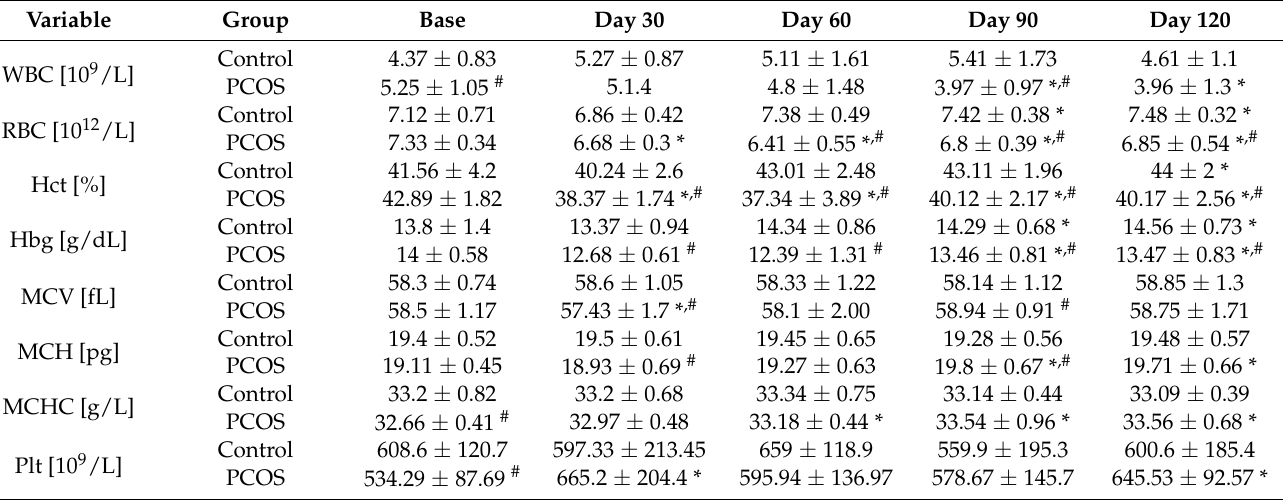
Table 4. Changes in the hematological parameters in Control and polycystic ovary syndrome (PCOS) group.